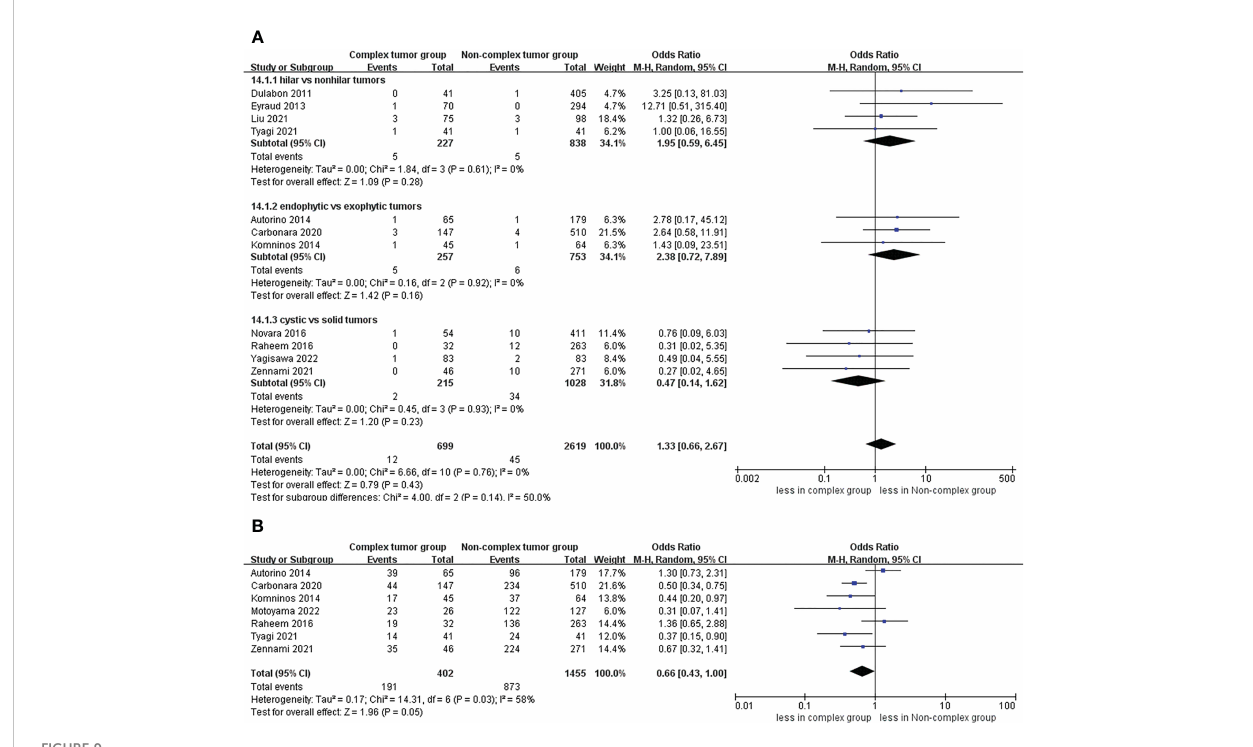
FIGURE 9 Funnel plot of oncologic outcomes (A) recurrence, (B) trifecta